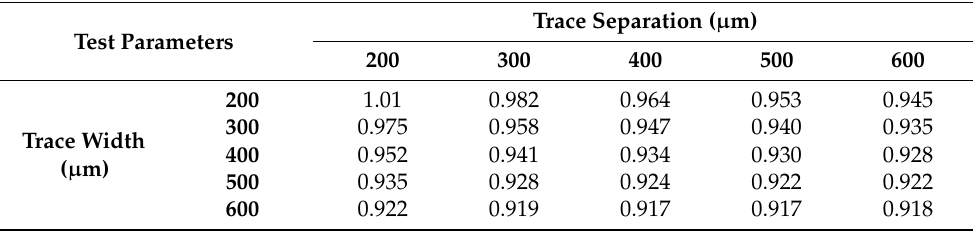
Table 6. Measured inductances of elliptical planar inductors for different combinations of trace sep- aration ( S ) and trace width ( W ) while major-to-minor ratio ( R ) = 3 and number of turns ( N ) = 5.